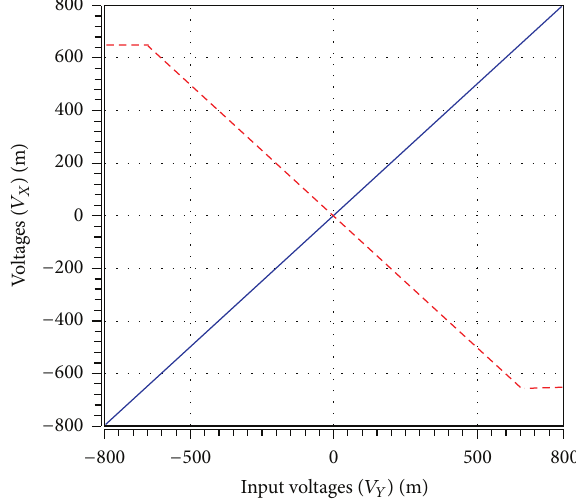
Figure 5: The DC characteristic between the 𝑌 (blue line) and 𝑋 (red line) terminals voltages of the ICCII.